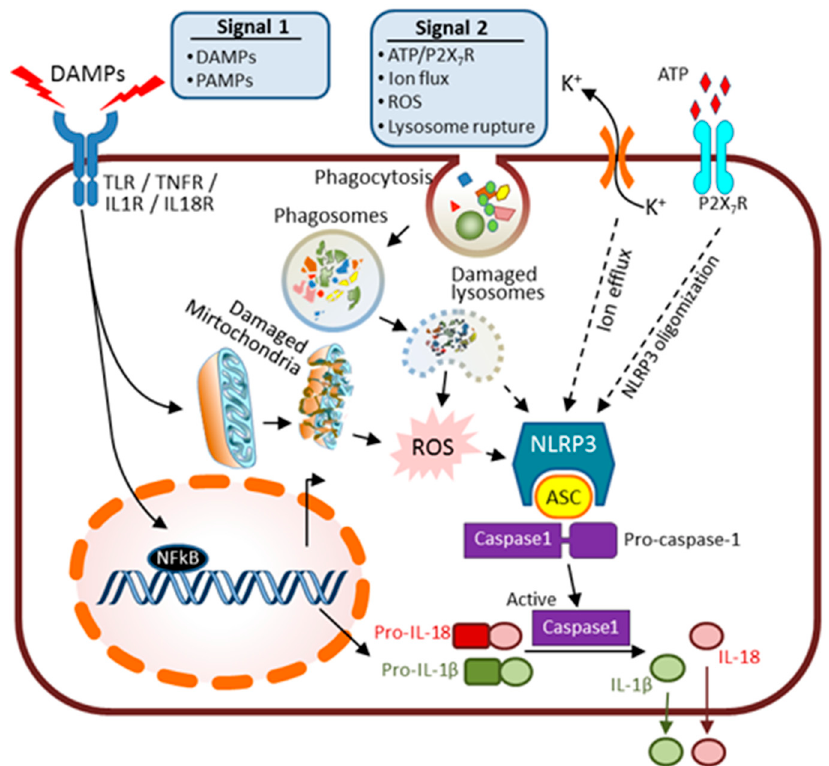
Figure 2. Inflammasome signaling acting in a two-step activation of IL-1 β and IL-18. Activation of the NLPR3 inflammasome requires two signals. Signal 1 involves the activation of TLRs, IL-1R, IL-18R and TNFRs by DAMPs or PAMPs which then induces the transcriptional activation of NF- κ B and subsequent production of pro-IL-1 β and pro-IL-18; Signal 2 involves different pathways such as ion (K + ) efflux, generation of ROS, ATP/P2X 7 R activation and lysosomal rupture/release of the endogenous cathepsins into the cytosol. Both signals coordinately induce assembly of the inflammasome complex: NLRP3 (sensor), apoptosis-associated speck-like (adaptor) and recruitment and enzymatic cleavage/activation of active caspase-1. Activated caspase-1 cleaves pre-forms of pro-IL-1 β and pro-IL-18 to release the pro-immunogenic IL-1 β and IL-18. Solid arrows indicate direct activation; dashed arrows indicate indirect activation.